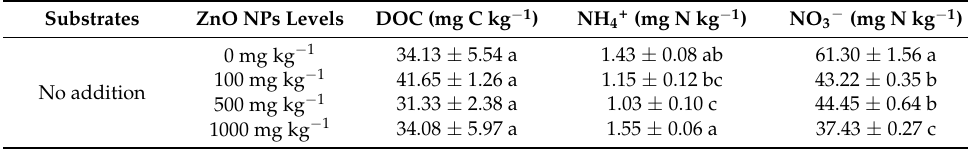
and N addition. Different letters indicate statistically significant differences (LSD,